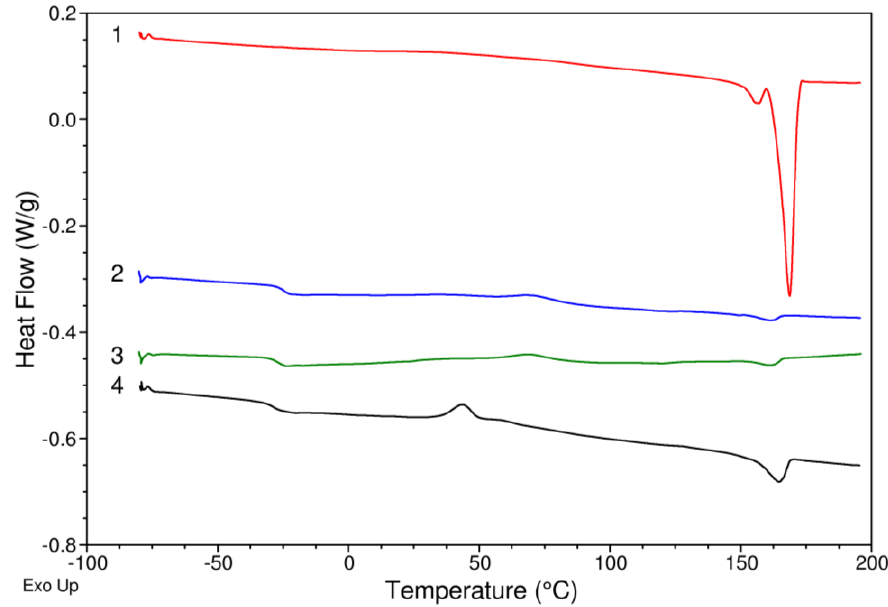
Figure 1. Results of DSC analysis of isolated polymers.